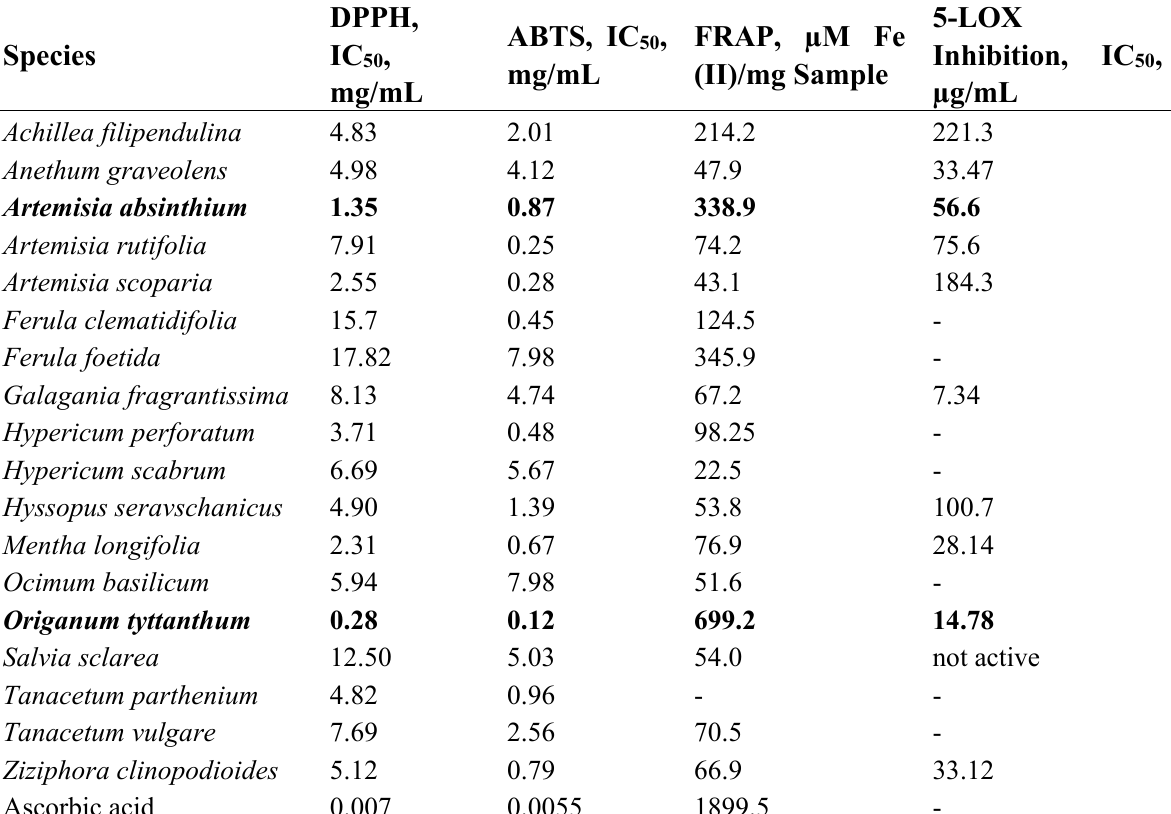
Table 3. Antioxidant and anti-inflammatory activity of essential oils from